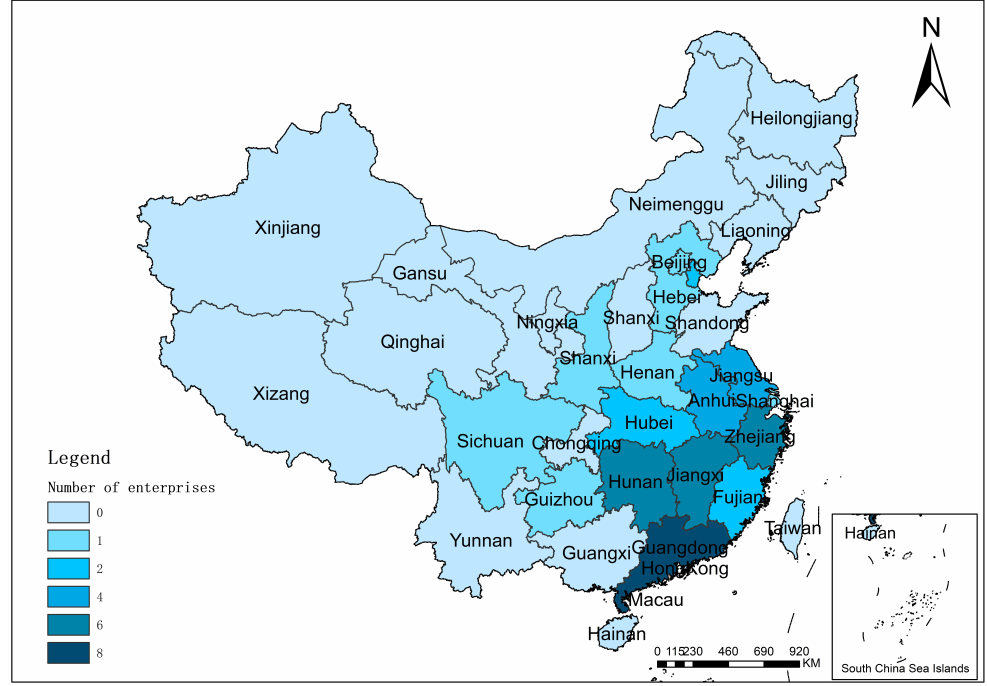
Figure 3. Location of whitelisting power battery enterprises in